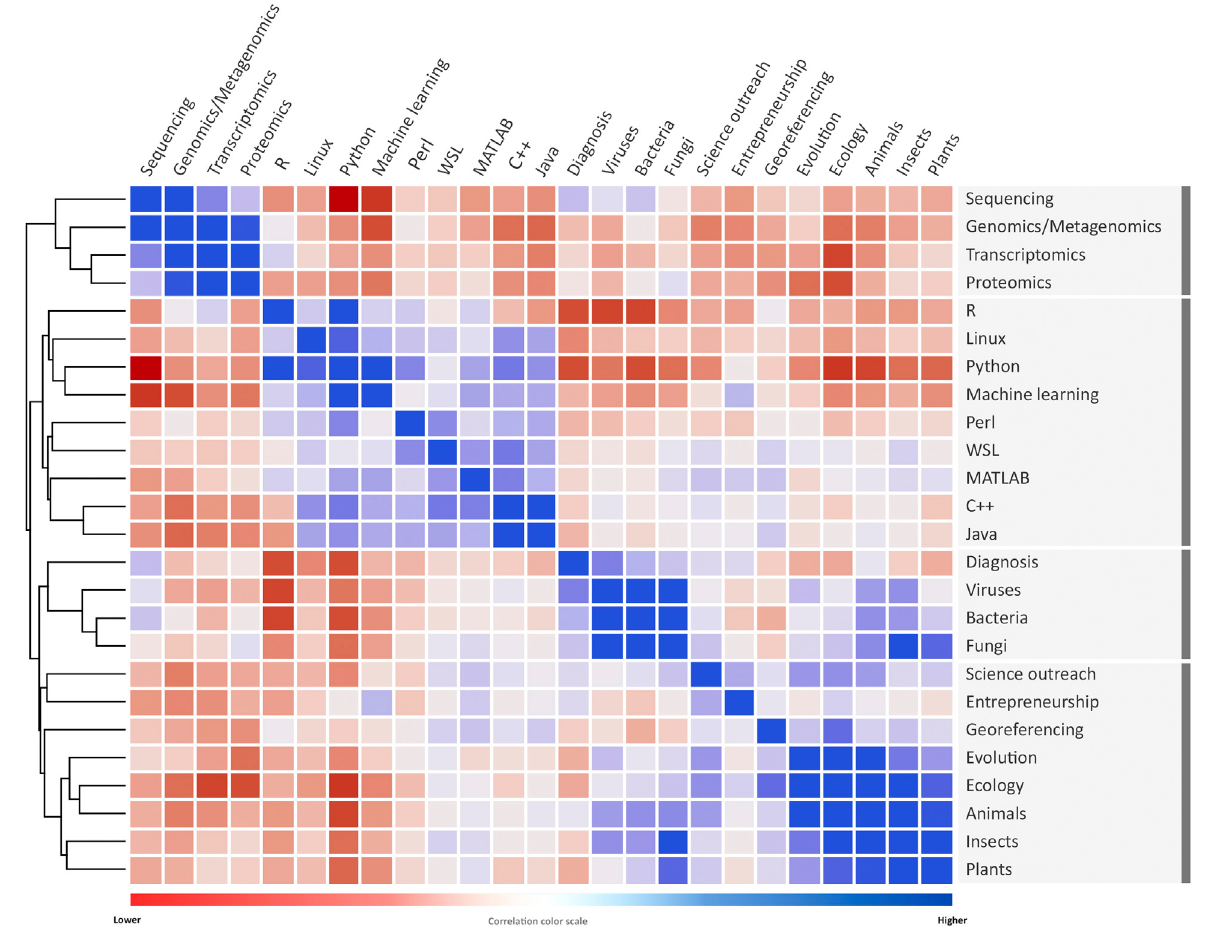
( Figure 3A ), representing a more diverse age group. The youngest attendee was 14 years old, while the oldest was 71 years old.